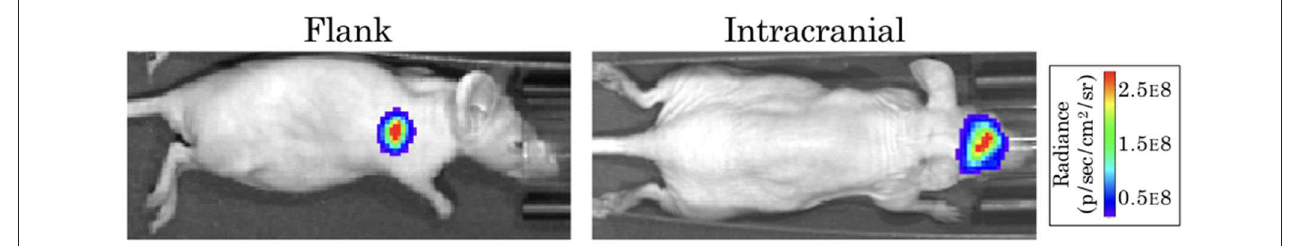
FIGURE 1 | Example bioluminescence images for patient-derived xenografts. Colors represent the BLI radiance (in photons/second/cm 2 /steradian), which is related to the BLI flux (measured in photons per second) for the total area.